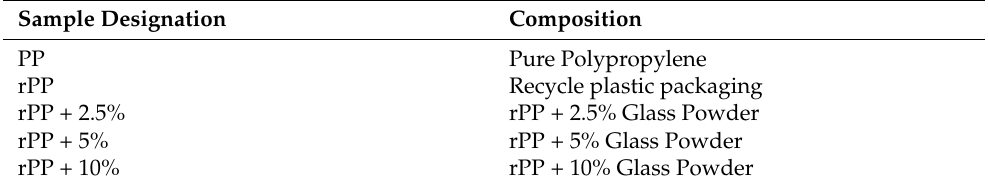
Table 2. The composition and designation of the